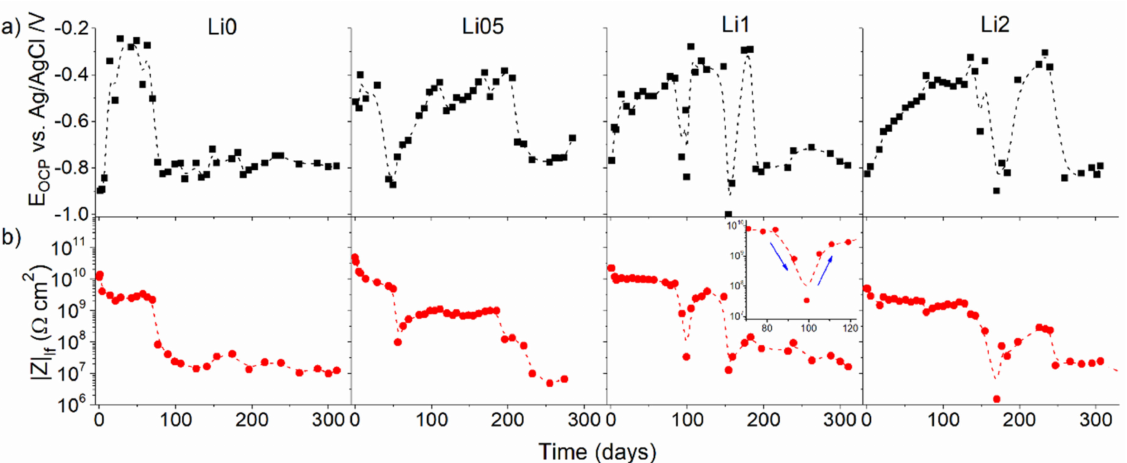
Figure 5. ( a ) Time evolution of EOC and ( b ) |Z| lf for coatings modified with different amounts of lithium during 310 days of immersion in 3.5% NaCl solution. The inset shows the first impedance modulus recovery (99 days) for the Li1 sample in more detail. Reproduced with permission of ACS